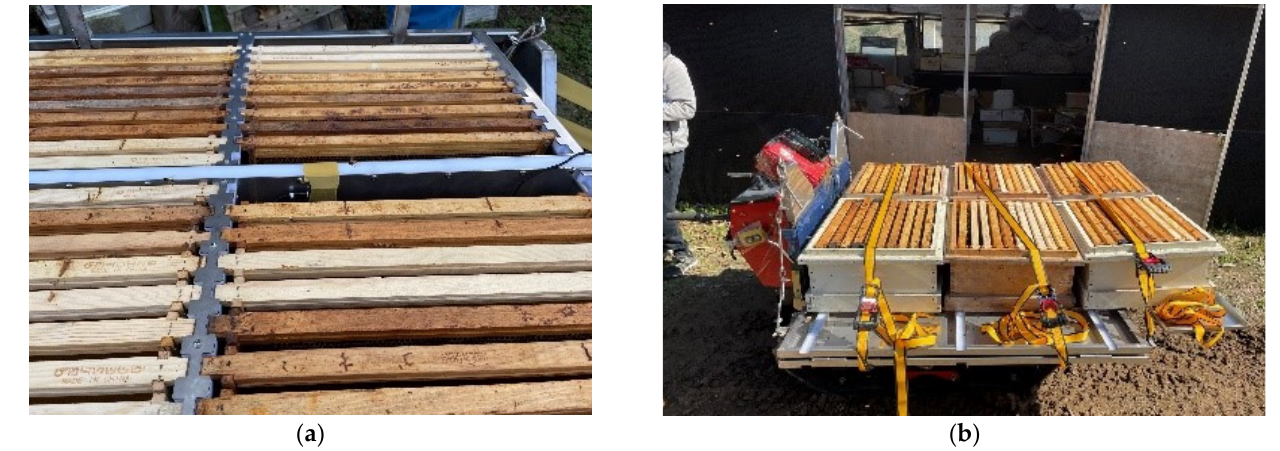
Figure 13. Experimental setup when the loading box is fully loaded with ( a ) bee frames and ( b ) beehives.